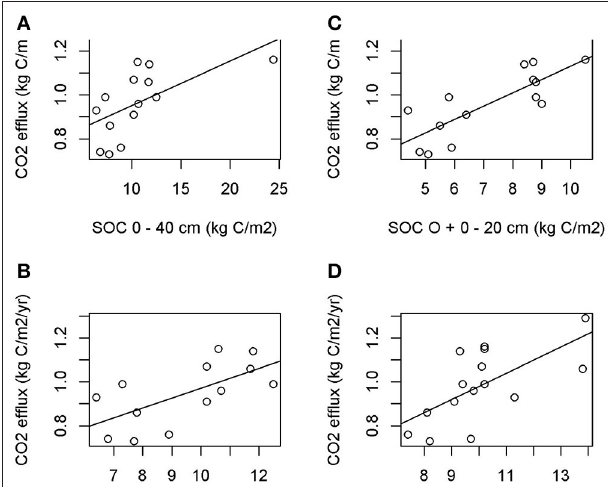
FIGURE 7 | Average soil respiration (2016 and 2017), kg C m − 2 yr − 1 vs. (A) measured SOC, kg C m − 2 (theoretical grid) R 2 = 0.37 . α = 0.75 ± 0.01 , β = 0.020 ± 0.008; (B) same as a), but without uncertain 24.4kg C m − 2 observation R 2 = 0.42 . α = 0.52 ± 0.01 , β = 0.045 ± 0.016 ; (C) vs. measured SOC in forest floor + 0–20cm mineral soil (theoretical grid) R 2 0.65, α = 0.53 ± 0.09, β = 0.060 ± 0.013, and (D) predicted SOC 0–40cm using the GPS/GNSS coordinates at the respiration plots. R 2 = 0.44 α = 0.38 ± 0.19 , β = 0.060 ± 0.020).